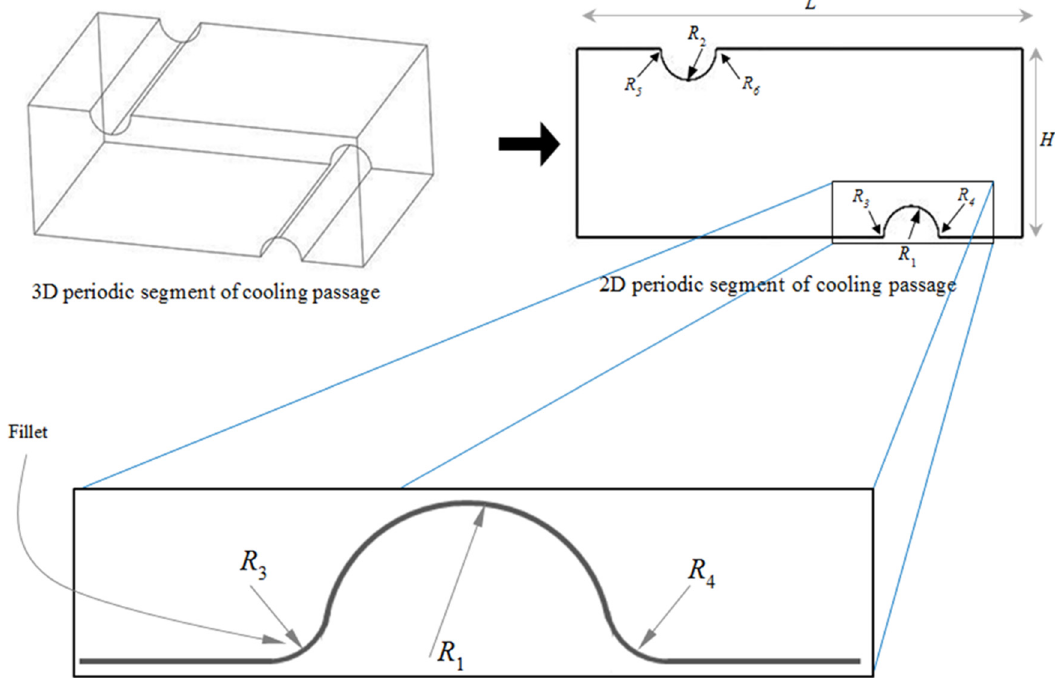
Fig. 2. Two-dimensional (2D) periodic section of the cooling channel and variables of